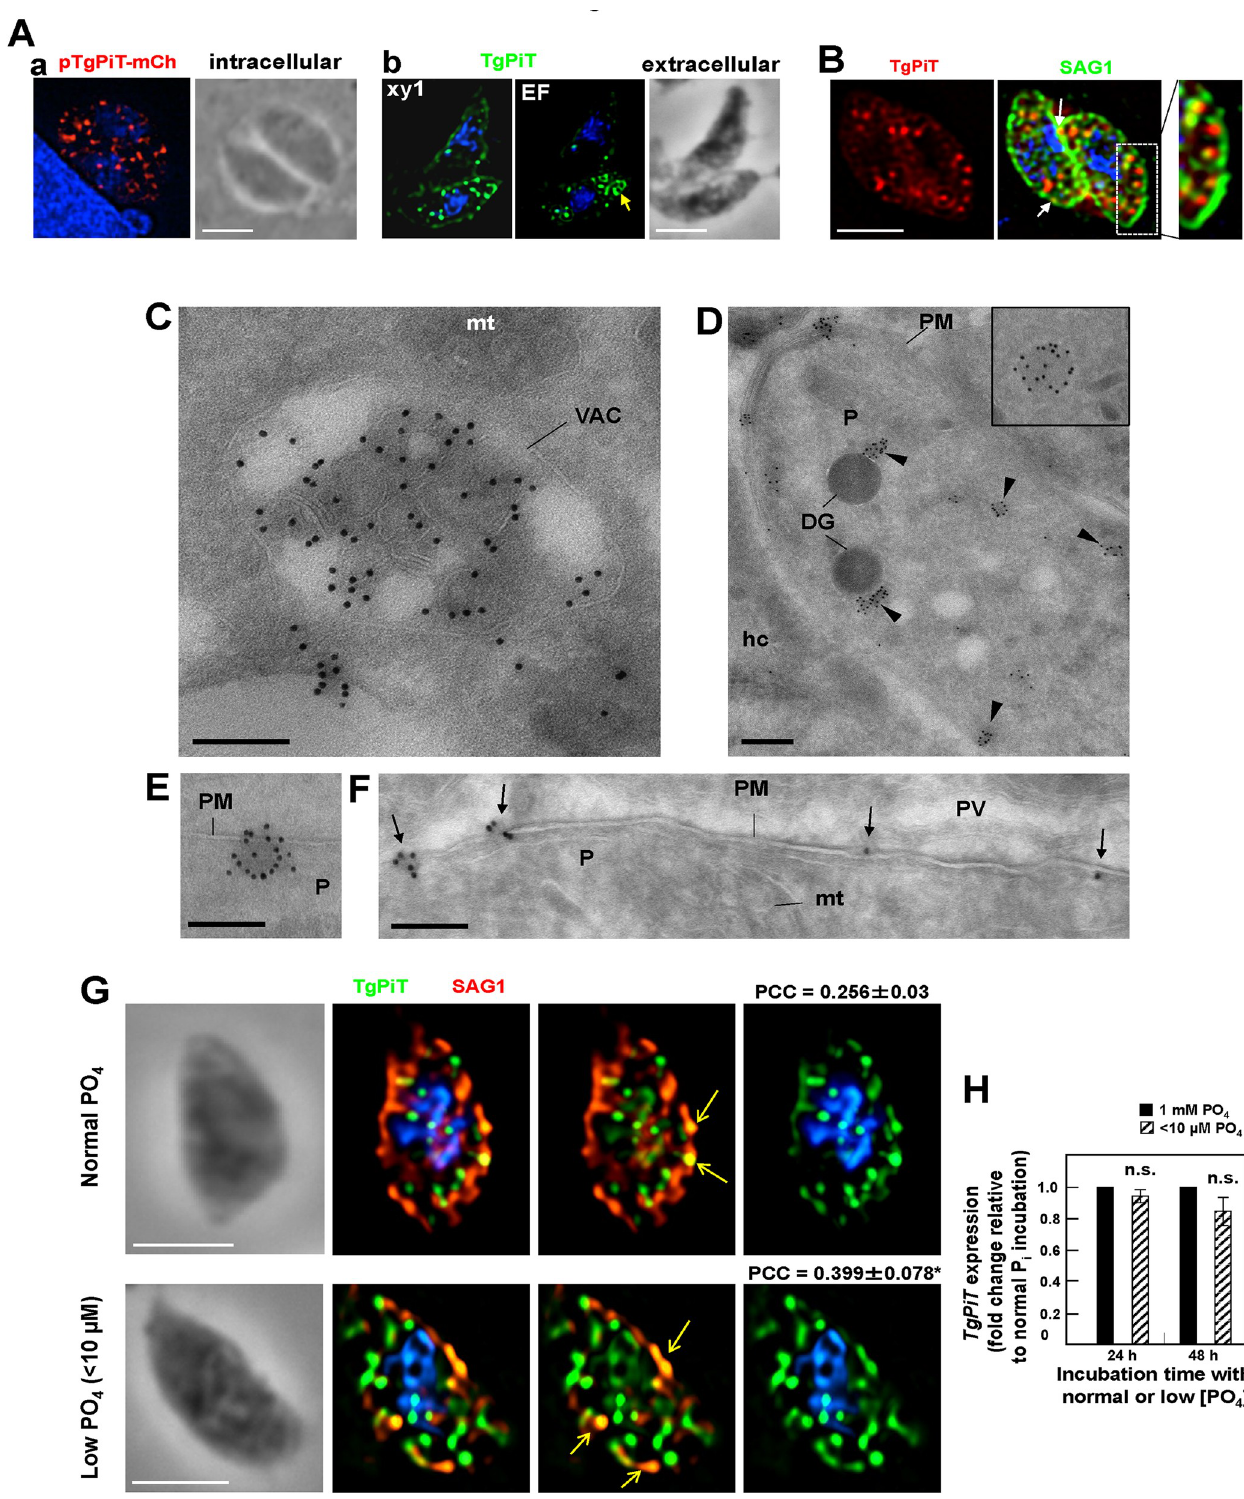
Fig 3. Localization of TgPiT in Toxoplasma . A. Panel a: Fluorescence microscopy of intracellular Toxoplasma transfected with a plasmid containing TgPiT- mCherry and visualized 16 h post-transfection. An individual z -slice is shown. Panel b: Fluorescence microscopy of extracellular Toxoplasma immunostained with rat anti-TgPiT antibodies. EF, extended focus, xy1, single z -slice. Both panels show intraparasitic puncta for TgPiT. Arrow in panel b points to a larger